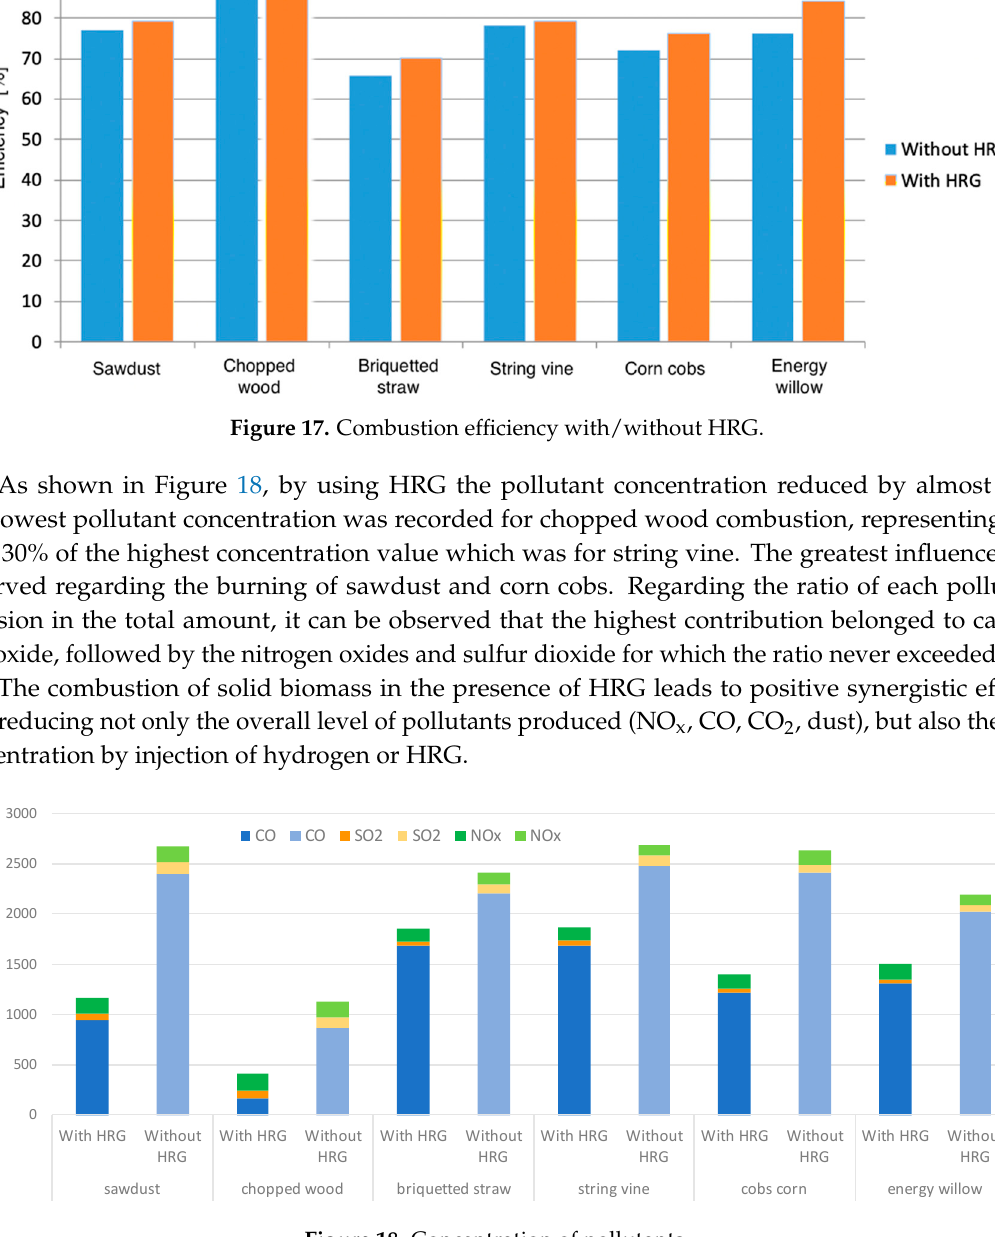
Figure 16. Flame shape: ( a ) obtained flame by burning chopped wood; ( b ) obtained flame by burning string vine; ( c ) obtained flame by burning corn cobs.